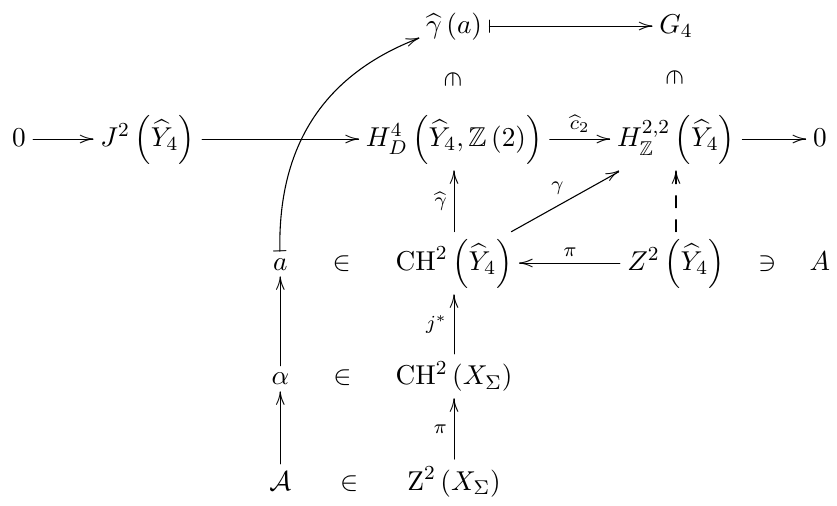
(cid:16) (cid:17) encode gauge backgrounds b Y 4